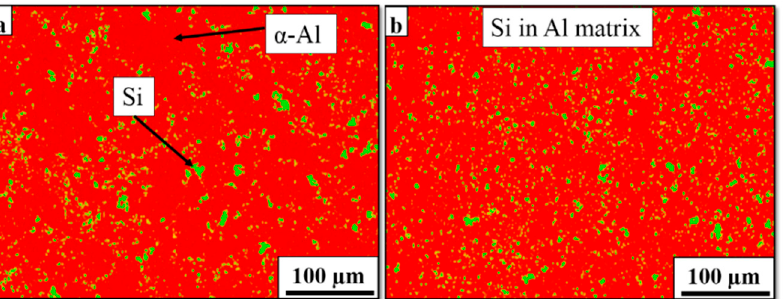
Figure 4. Mapping of the HPTed A356 Al alloy pre-T6 at the ( a ) centre and ( b ) edge by 5 turns.